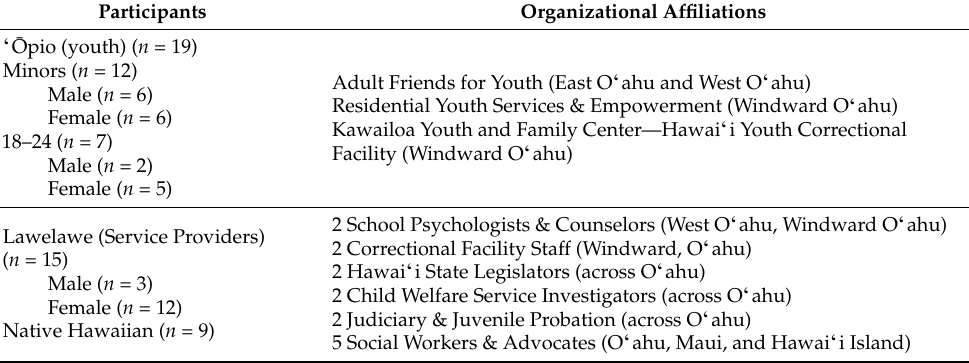
Table 1. Demographics ( n =